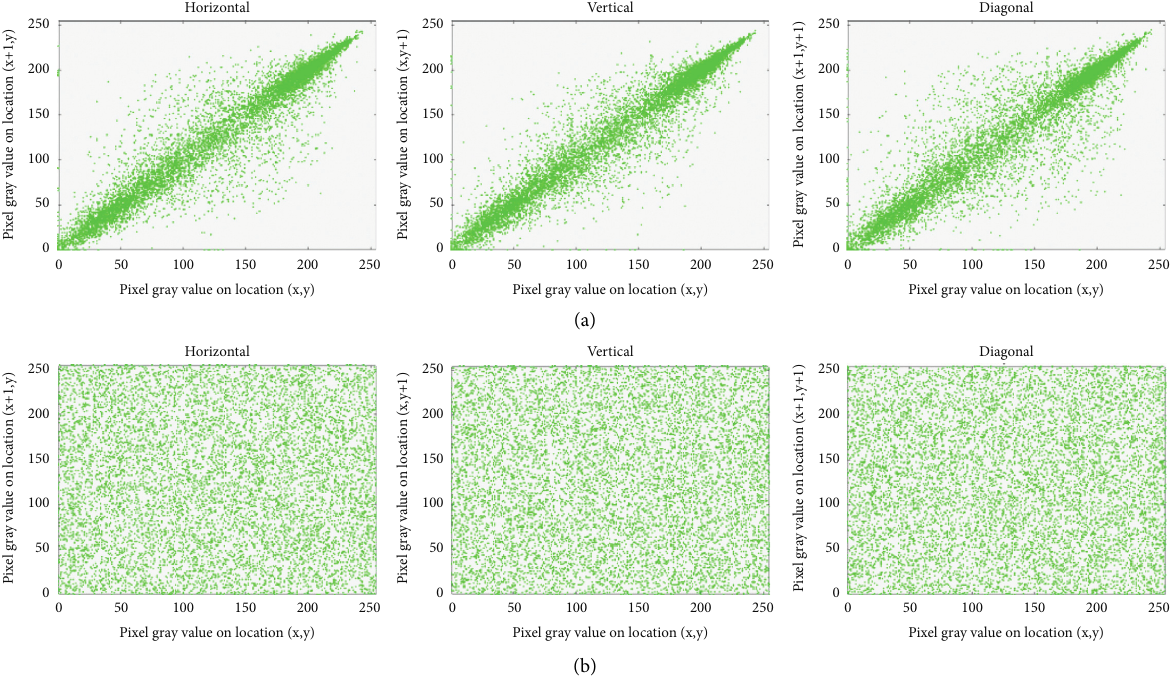
Figure 7: Correlation distribution for green component of plain composite image in Figure 4(a) (a) and those from the cipher composite image in Figure 4(b)